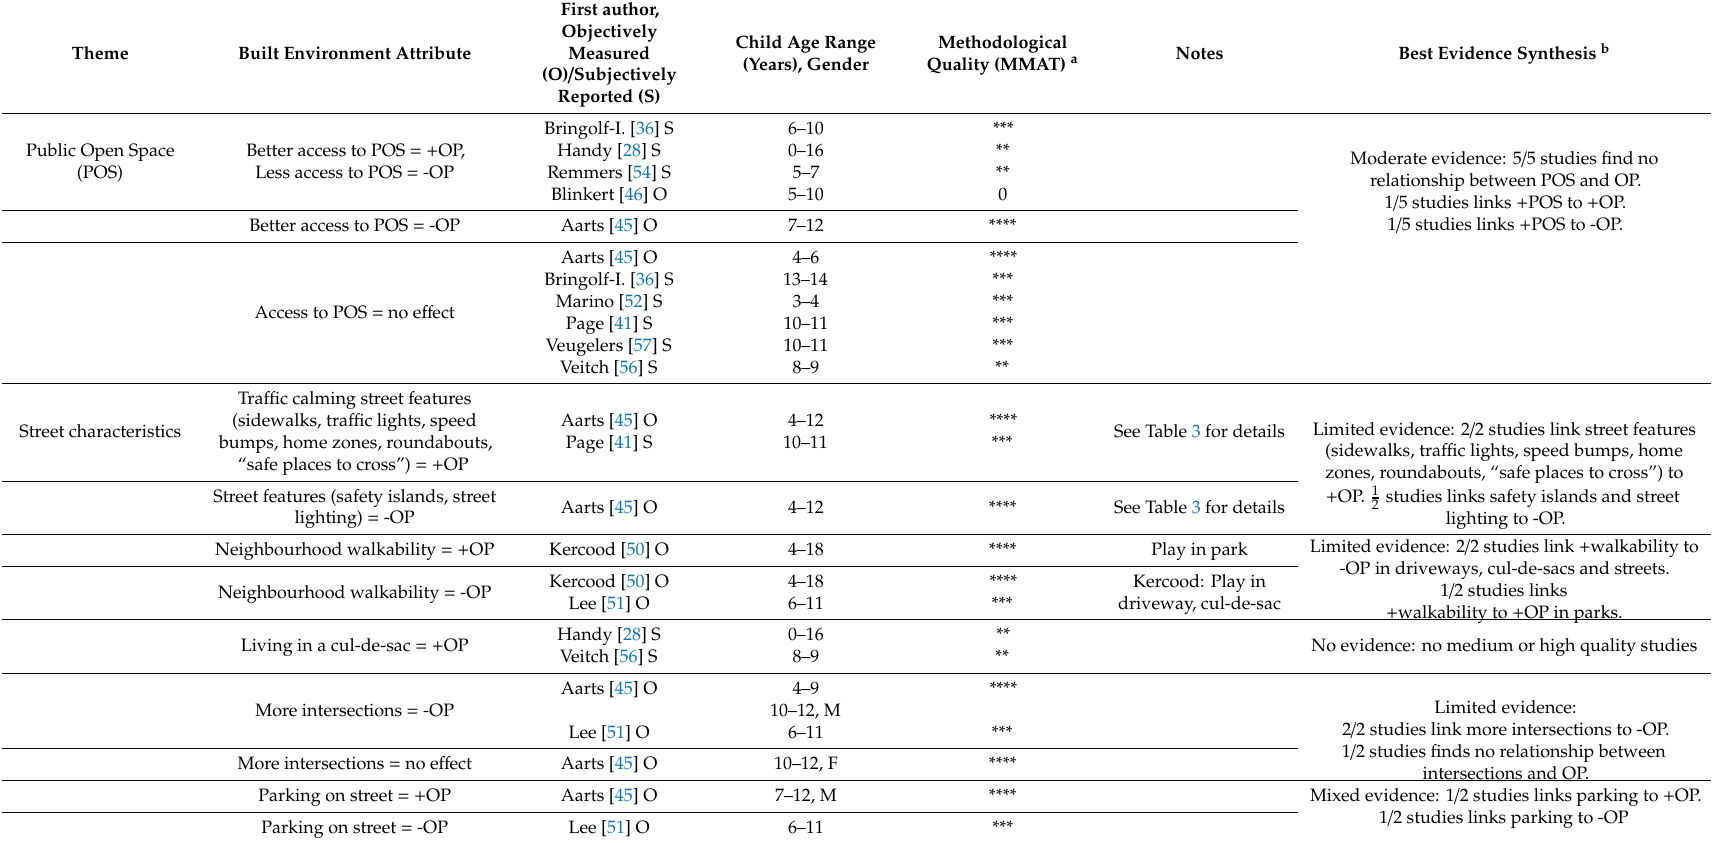
Table 4. Best evidence